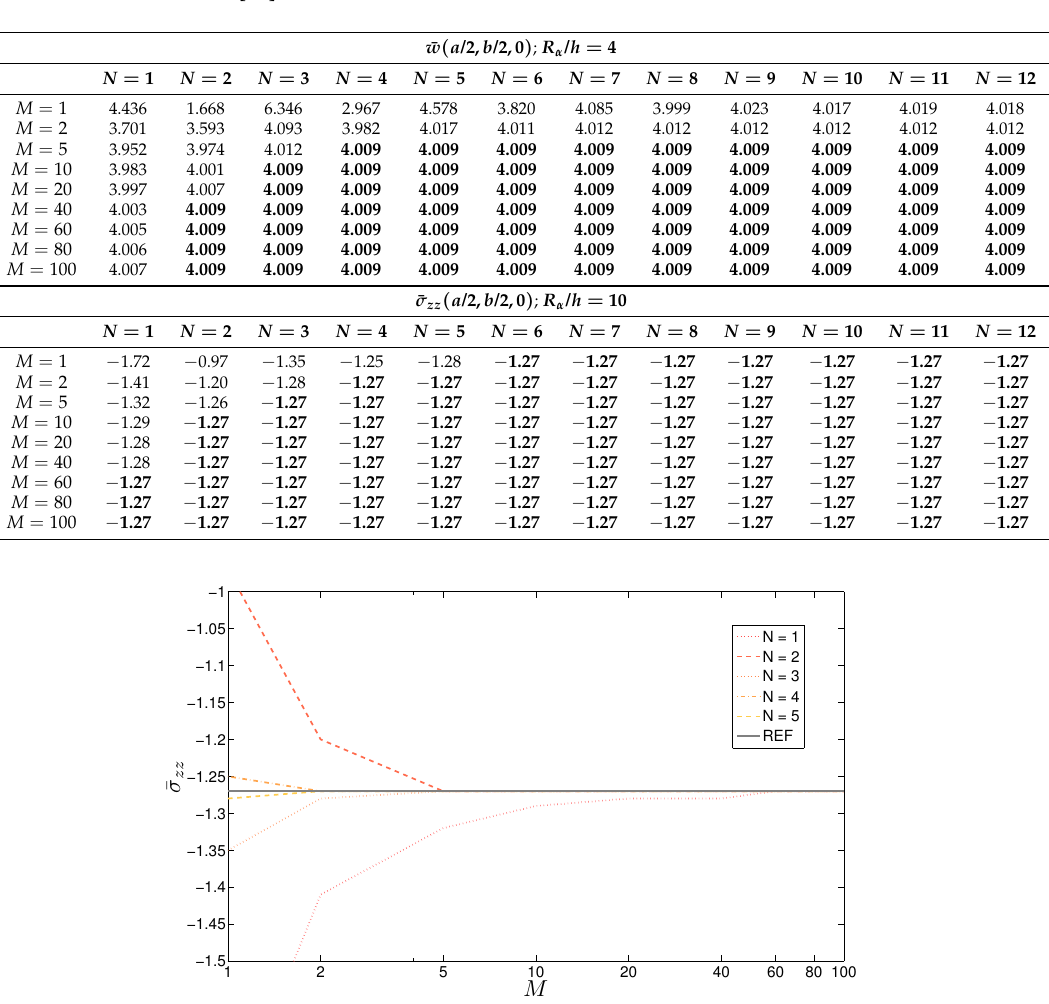
Table 5. Case 3. Composite laminated cylinder. Displacement ¯ w for thickness ratio R α / h = 4 and stress ¯ σ zz for thickness ratio R α / h = 10, both evaluated in the middle and given as dimensionless values. Each physical layer ( N L = 3) is divided into M mathematical layers. 3D reference solution by Varadan and Bhaskar [15].